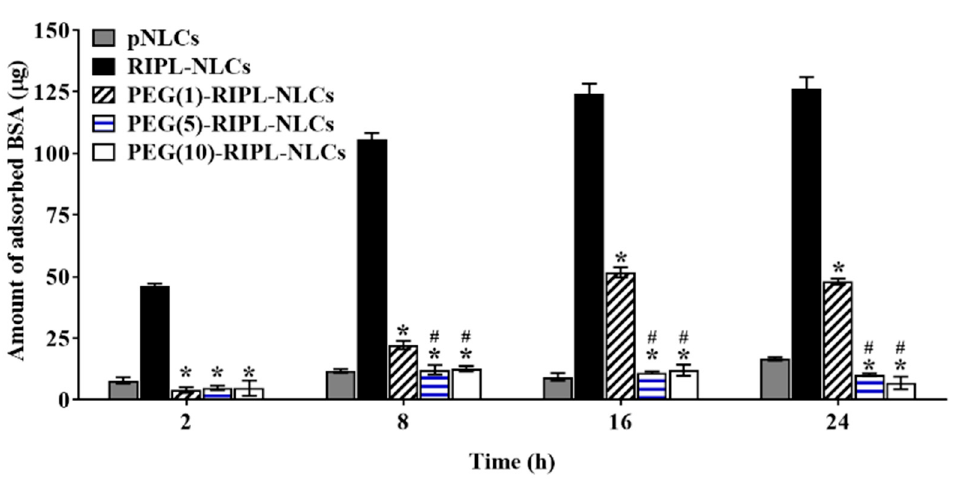
Figure 3. Bovine serum albumin (BSA) adsorption on various NLCs as a function of time. * p < 0.05 versus RIPL peptide-conjugated NLCs (RIPL-NLCs); # p < 0.05 versus PEG (1 mole %)-grafted RIPL-NLCs (PEG(1)-RIPL-NLCs).